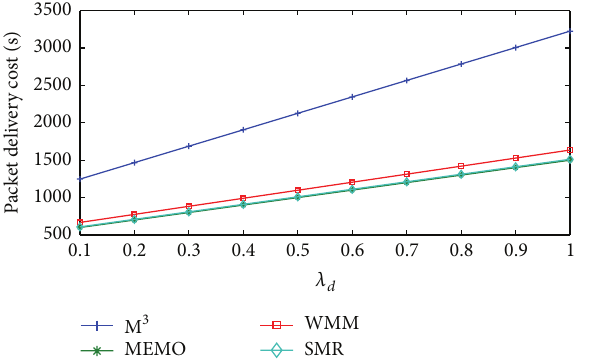
Figure 10: Handoff cost/sec versus 𝜆 𝑠 .